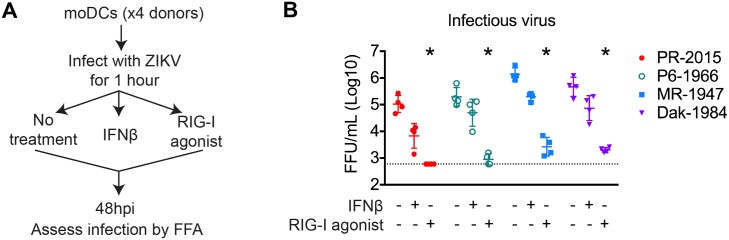
Innate immune signaling restricts ZIKV viral replication within human DCs.(A) moDCs were infected with PR-2015, P6-1966, MR-1947, or Dak-1984 at MOI of 1 (n = 4 donors). After viral attachment and entry at 1hpi, cells were treated with RIG-I agonist (10ng/1e5 cells), human IFNβ (100 IU/mL), or left untreated. (B) Supernatants were collected at 48hpi and assessed for infectious virus release by FFA. Values for each individual donor are shown with the mean +/- SD. Statistical significance (p< 0.05) was determined using a Friedman test with comparisons made to donor-paired, untreated, ZIKV-infected cells. The assay limit of detection is indicated with a dashed line.